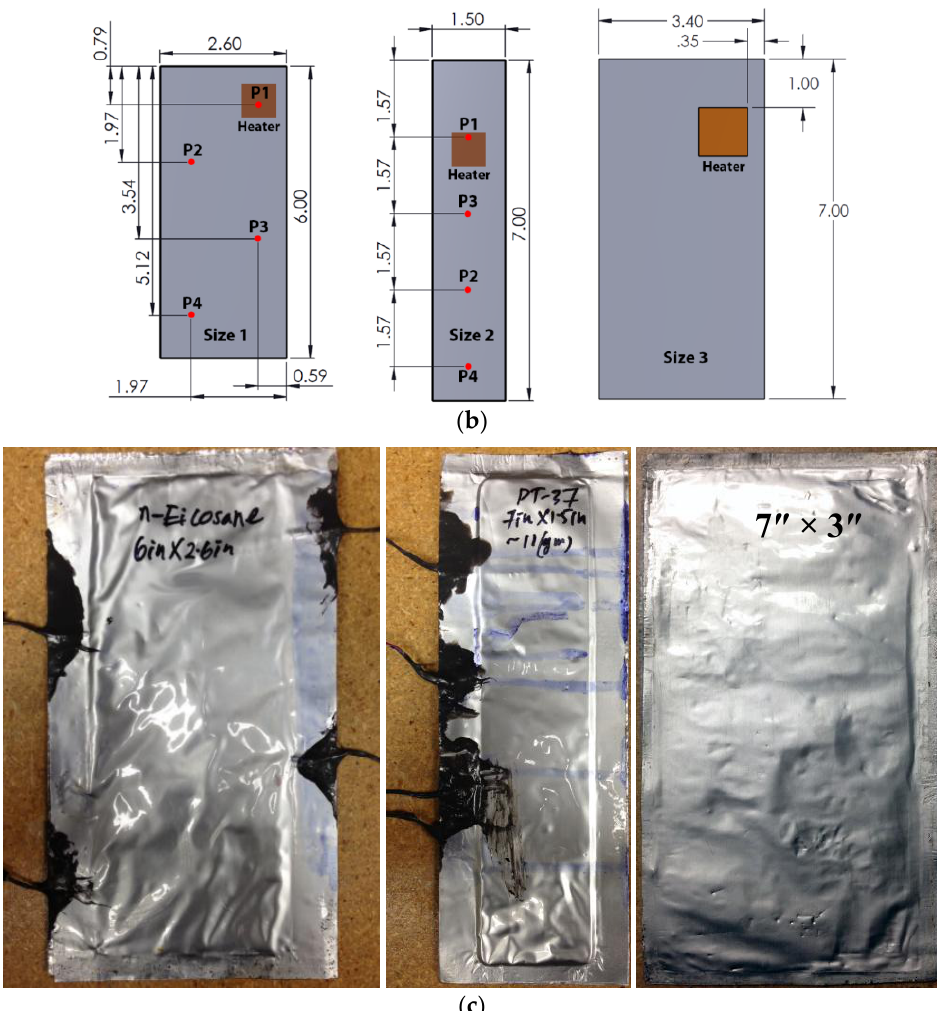
Figure 2. ( a ) Positions of thermocouples attached to internal components and to front and back surfaces of the mock tablet PC (F—Front, B—Back), ( b ) schematics of the three different sized encapsulations with positions of thermocouples relative to the tablet PC heater (dimensions in inches) ( c ) photographs of PCM encapsulations: Size 1 ( Left ), Size 2 ( middle ), Size 3 ( right ).